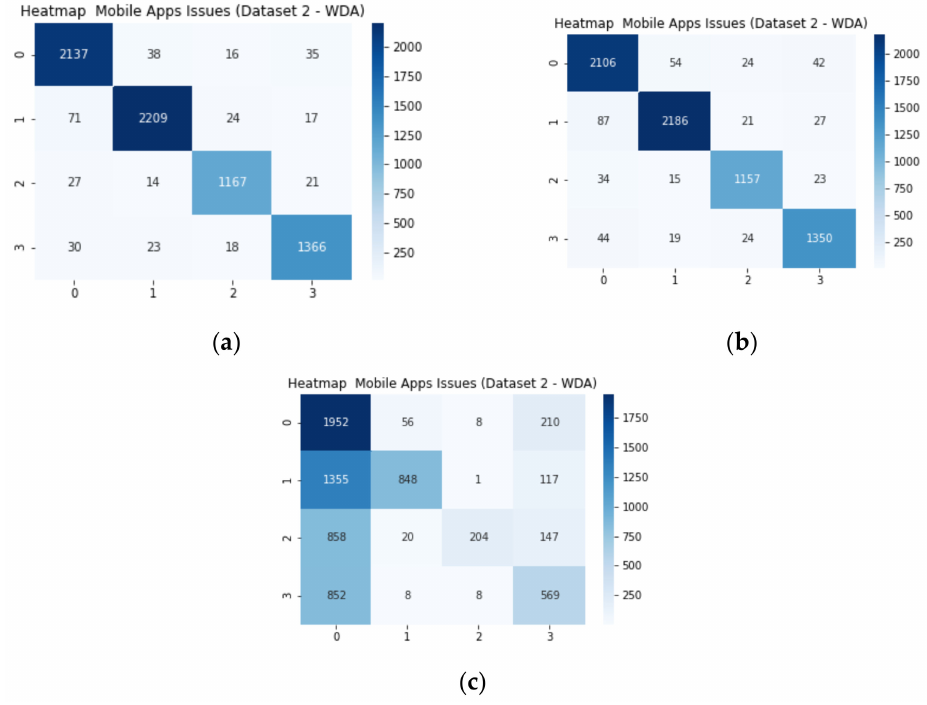
Figure 9. Confusion matrix for ML classifiers using dataset 2 with data augmentation: ( a ) RF, ( b ) SVC, ( c )